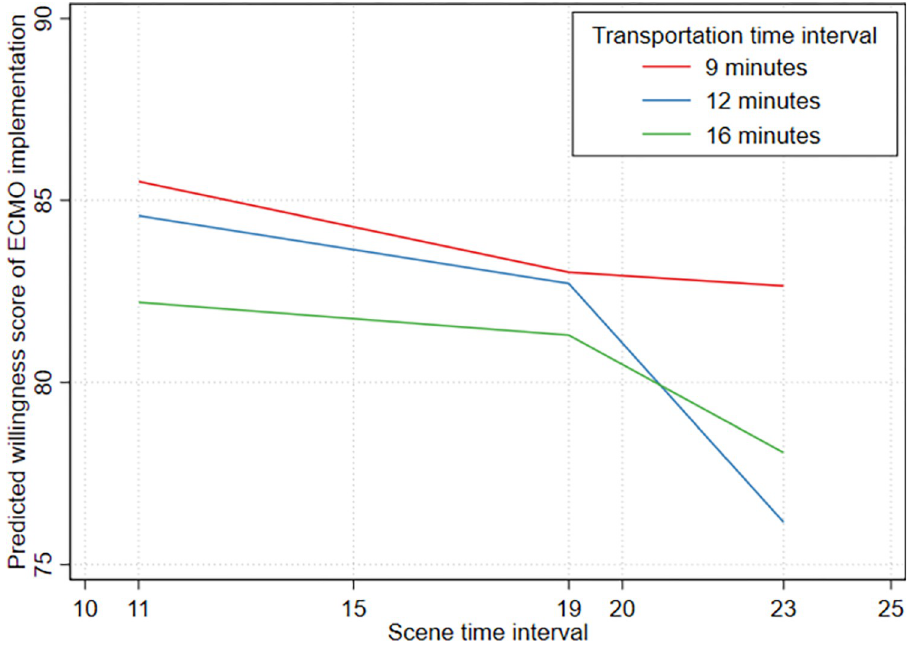
Fig 1. The interaction between scene time interval and transportation time